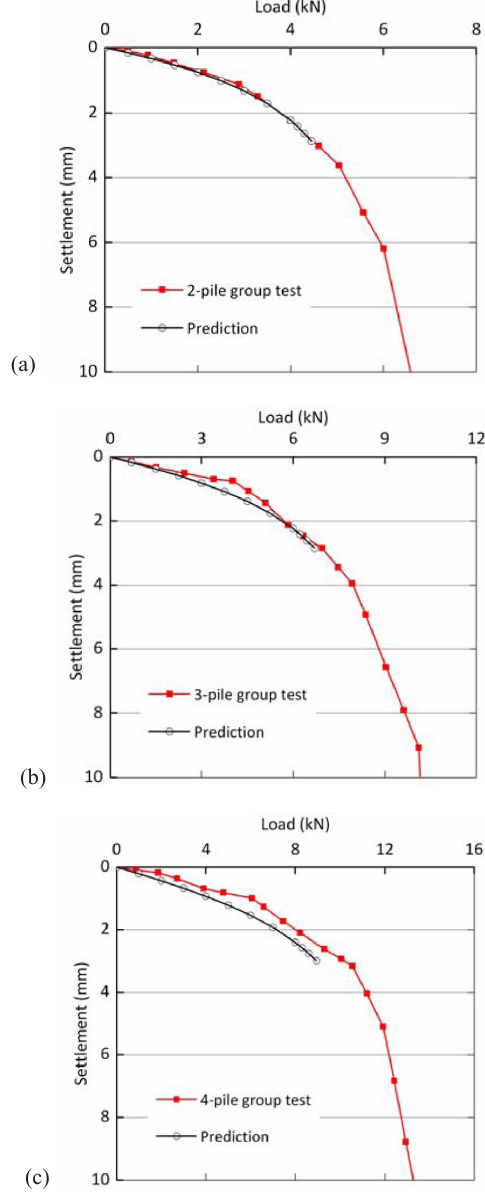
Fig. 16. Comparison of measured and predicted pile group response in medium dense sand ( S/B = 3): (a) 2-pile group; (b) 3-pile group; (c)